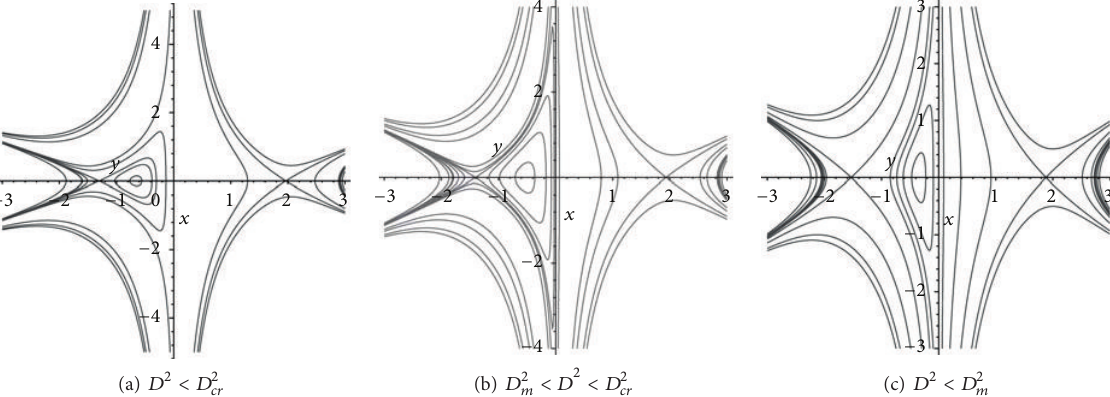
Figure 11: The changes of phase portraits of system (6) when 𝐷 2 are decreased. Parameters: 𝑛 = 2𝑚 , 𝛽 < 0 , 𝐺 1 < 0 , and 𝜎 > 0 .